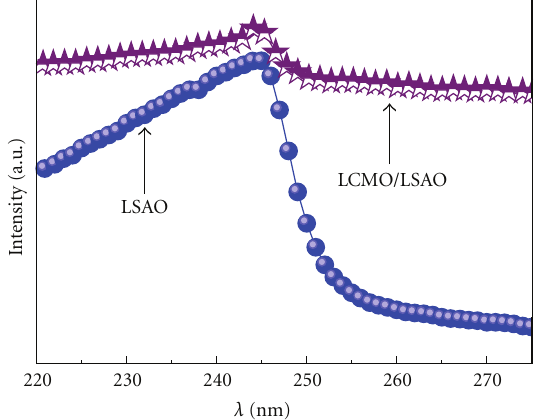
Figure 4: The absorption spectra of the LCMO/LSAO sample and LSAO single